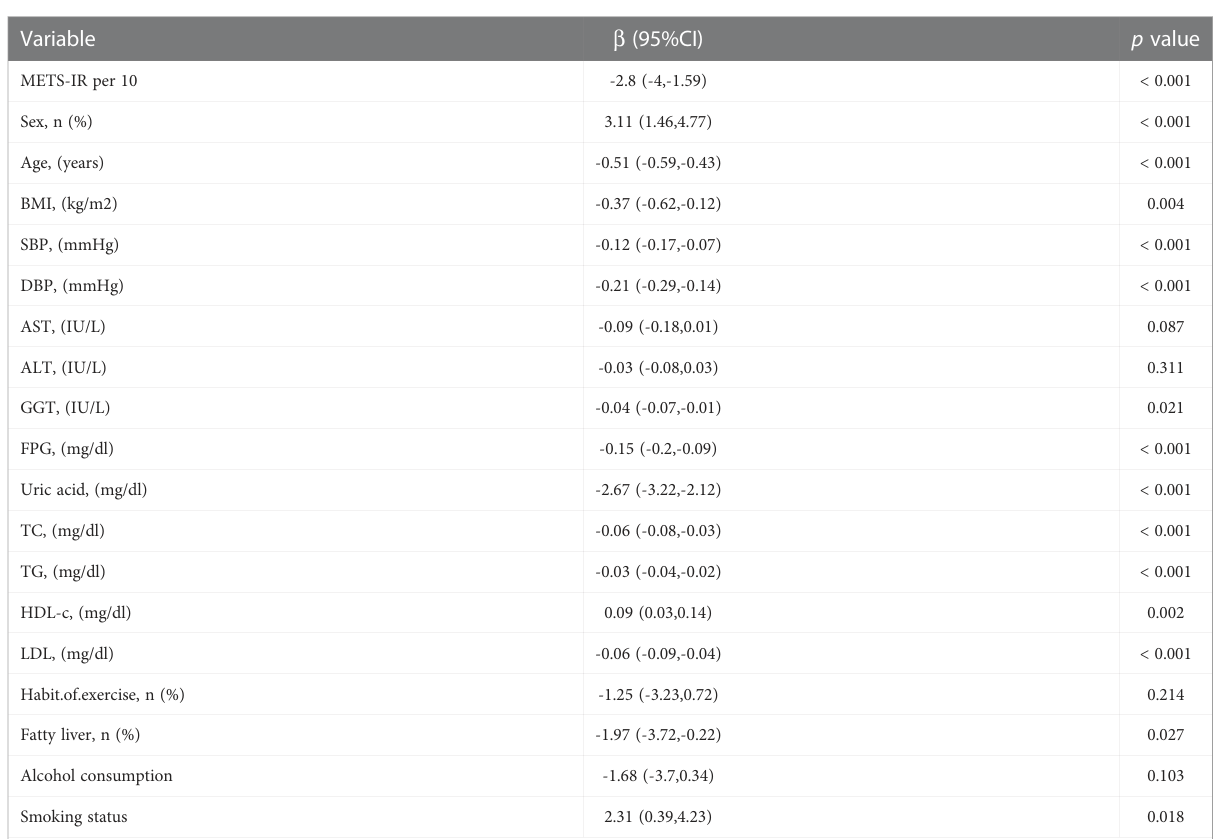
TABLE 2 Results of univariate analysis of eGFR.